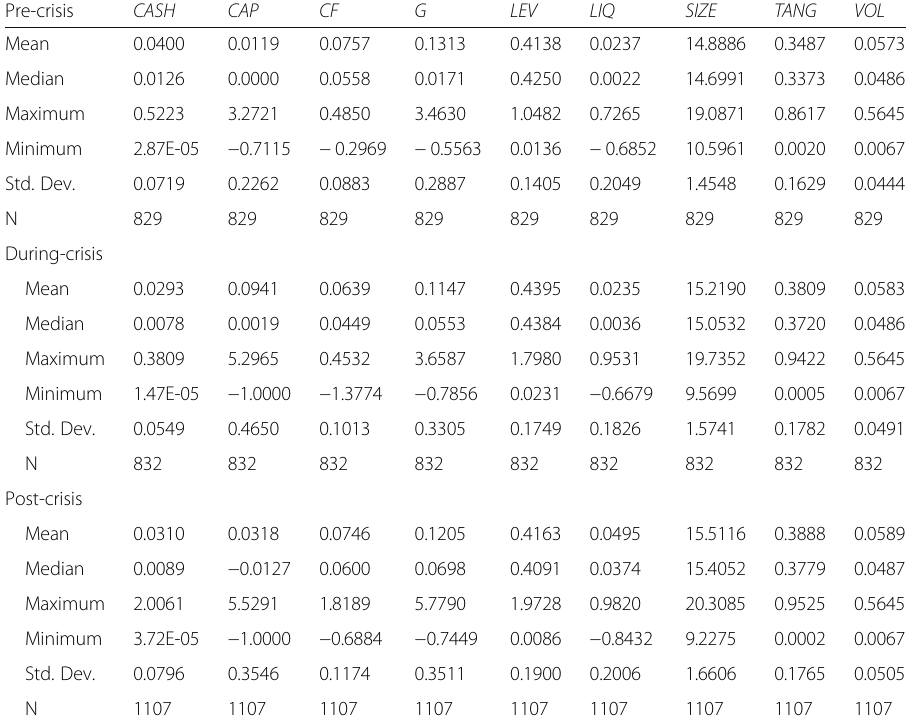
Table 2 Summary